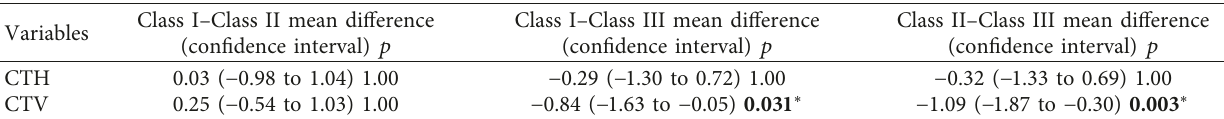
Table 6: Intergroup comparison of chin variables among different sagittal skeletal